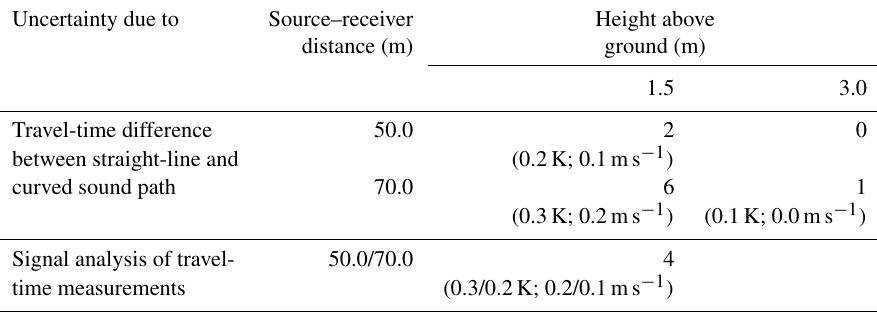
Table 4. Comparison of travel-time uncertainties. Above: travel-time difference (in sample units), recalculated temperature and wind speed differences in brackets, between straight-line and curved sound path through the atmosphere for a maximum vertical gradient of effective sound speed of 0.6s − 1 (during nighttime) on a summer day over grassland. Below: travel-time uncertainty (temperature and wind speed uncertainty in brackets) due to signal analysis using CCF, see Sect.